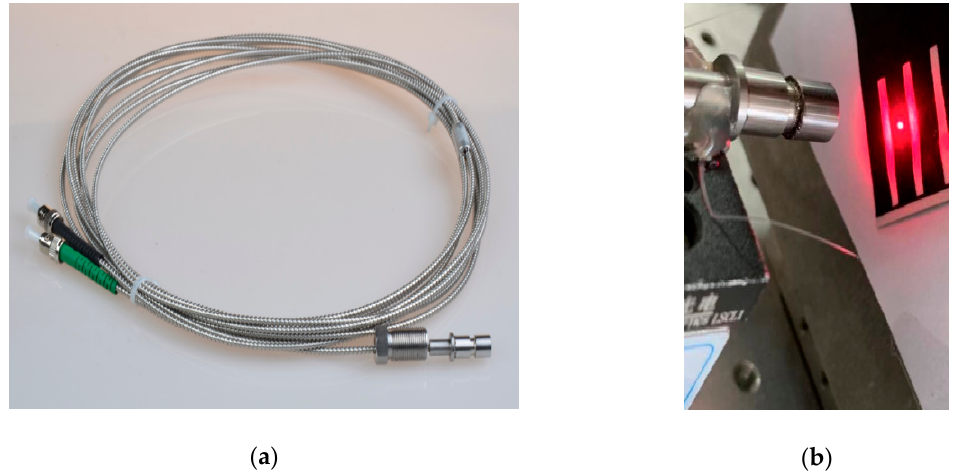
Figure 4. ( a ) Photograph of a fiber optical sensor with a lens. ( b ) Photograph of the measuring spot when the working distance is 19 mm.